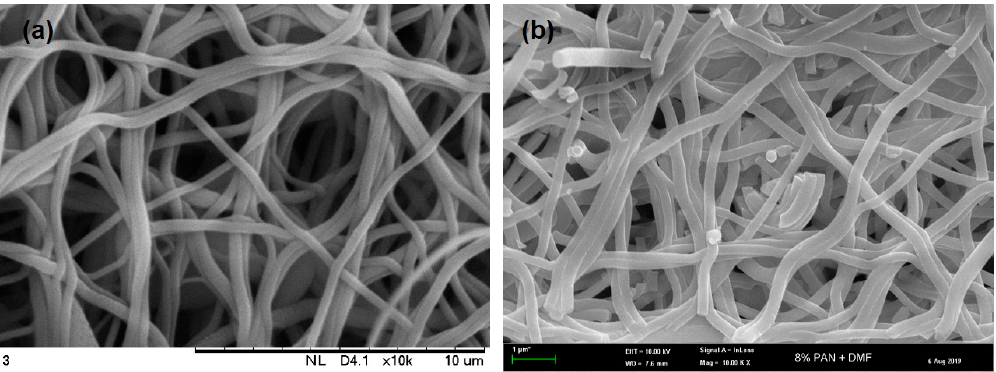
Figure 5. The morphology of pristine nanofibers ( a ) prior to activation and ( b ) after activation.